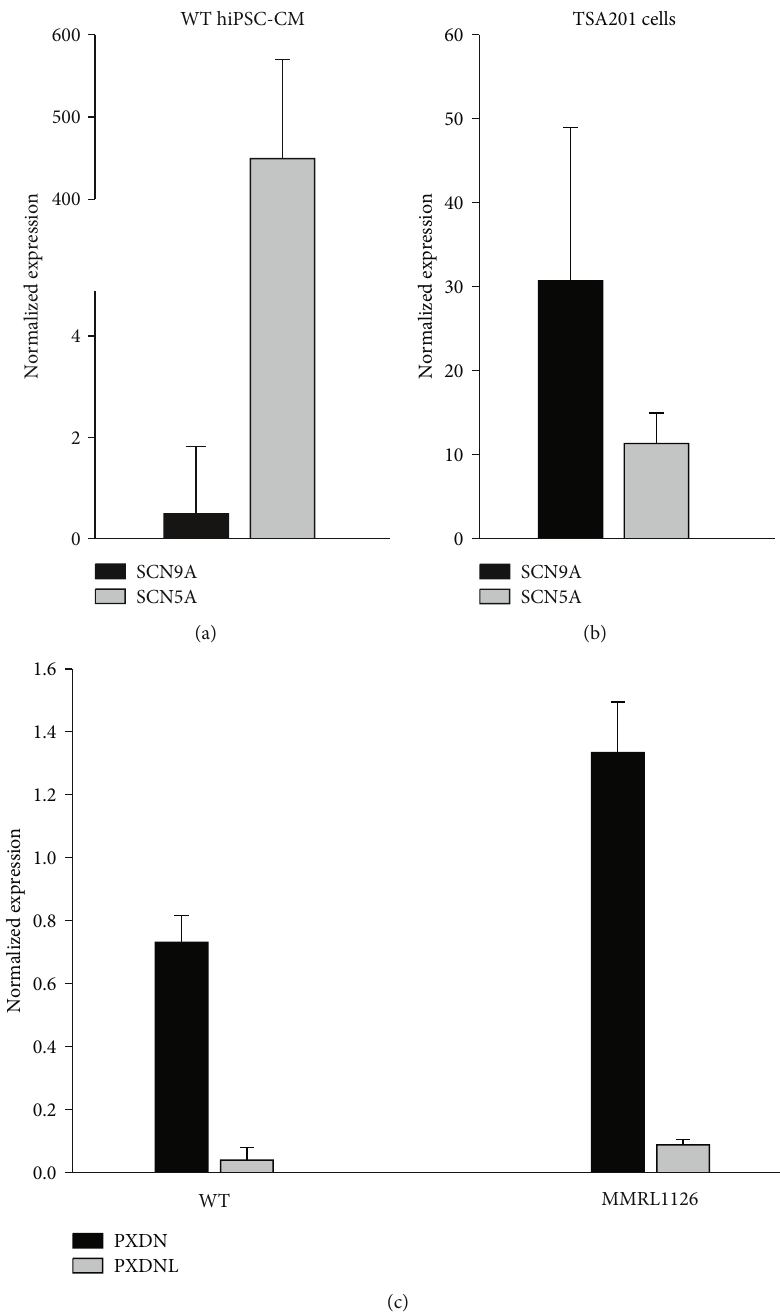
Figure 7: RT-qPCR analysis of SCN9A and SCN5A in hiPSC-CMs (normalized to GAPDH). SCN5A message was highly expressed, whereas levels of SCN9A were negligible in the hiPSC-CMs (a). RT-qPCR analysis of SCN9A and SCN5A in TSA201 cells transfected with SCN5A and SCN9A plasmid at a 1 :1 molar ratio. SCN9A message could readily be detected in transfected TSA201 cells (b). RT-qPCR analysis of PXDN and PXDNL in hiPSC-CMs (c). PXDNL was expressed at low levels in both WT and MMRL1126